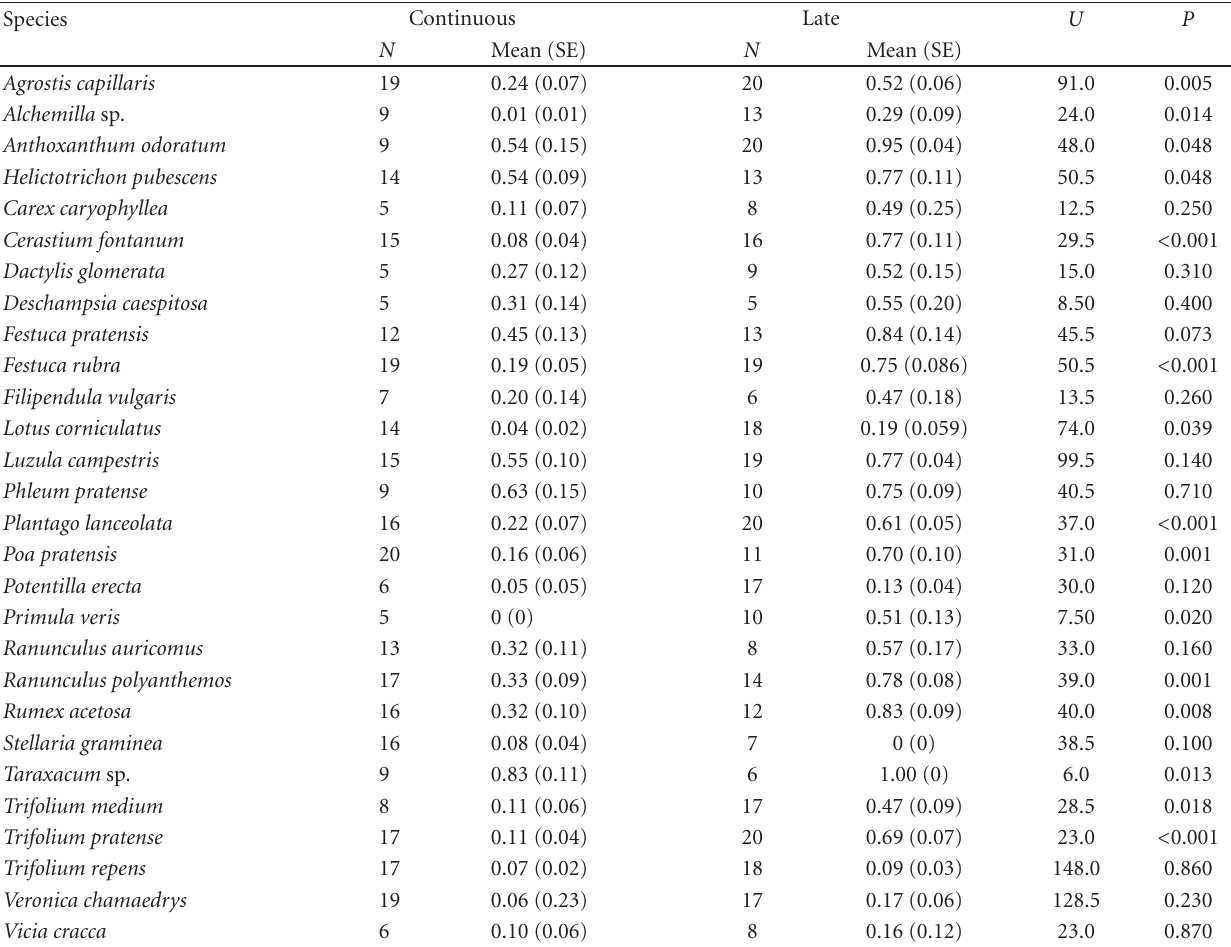
Table 2: Mean relative fruit production of 28 species occurring in five or more plots per the two grazing regimes: continuous stocking and late grazing, in the grassland Harpsund, see text for details. Di ff erences between grazing regimes are tested using the Mann-Whitney U -test. N -values show the number of plots in which the species were